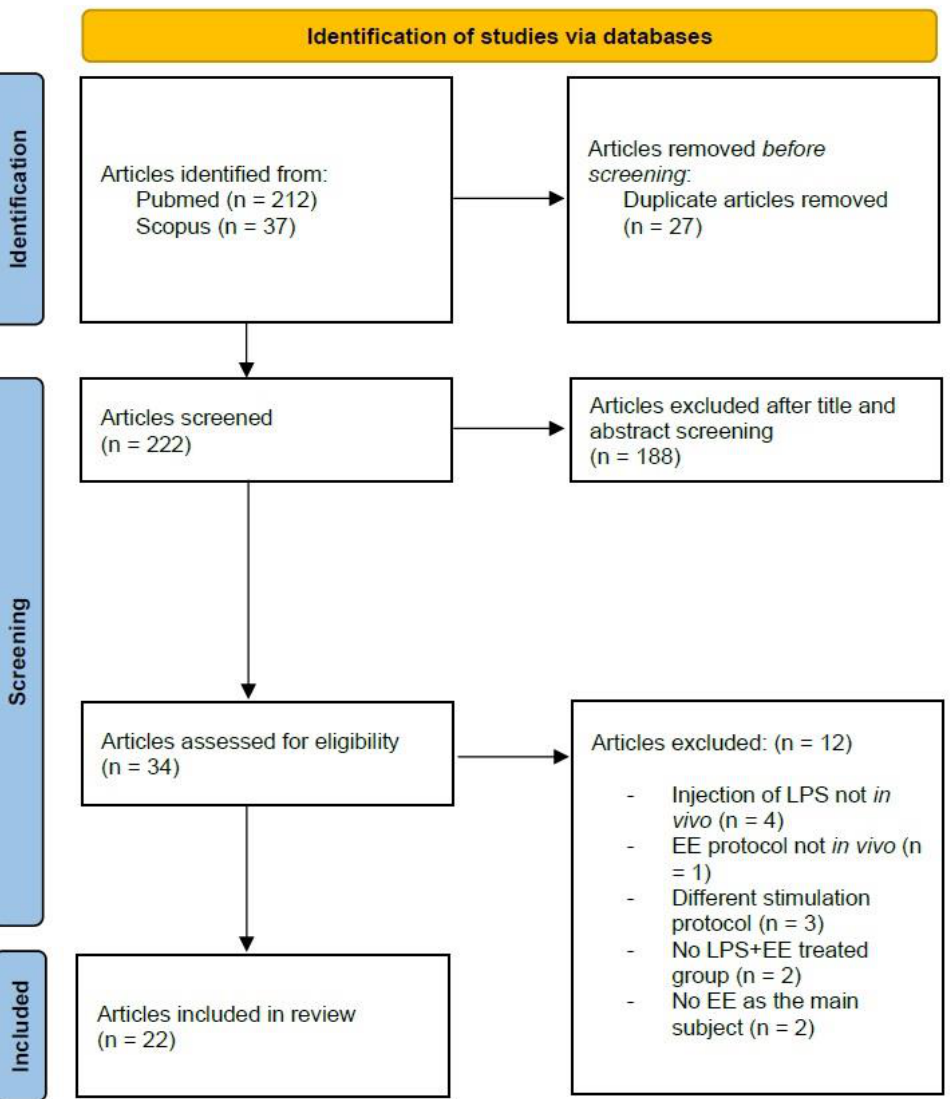
Figure 2. Search flow diagram based on PRIMA guidelines [66]. EE: environmental enrichment; LPS: